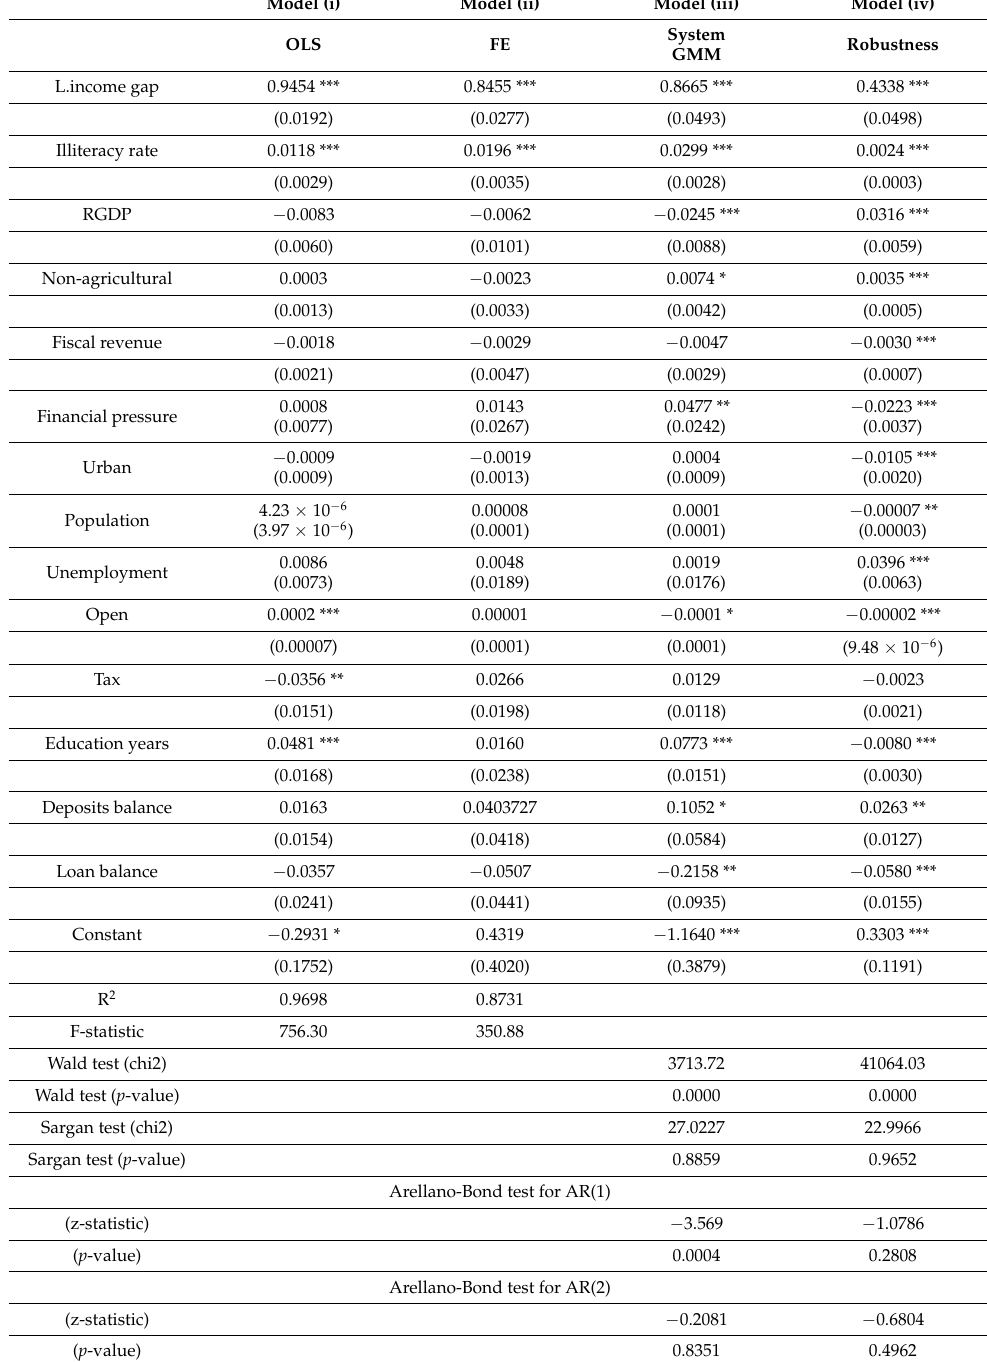
Table 3. The influence of farmers’ education level the on rural–urban income